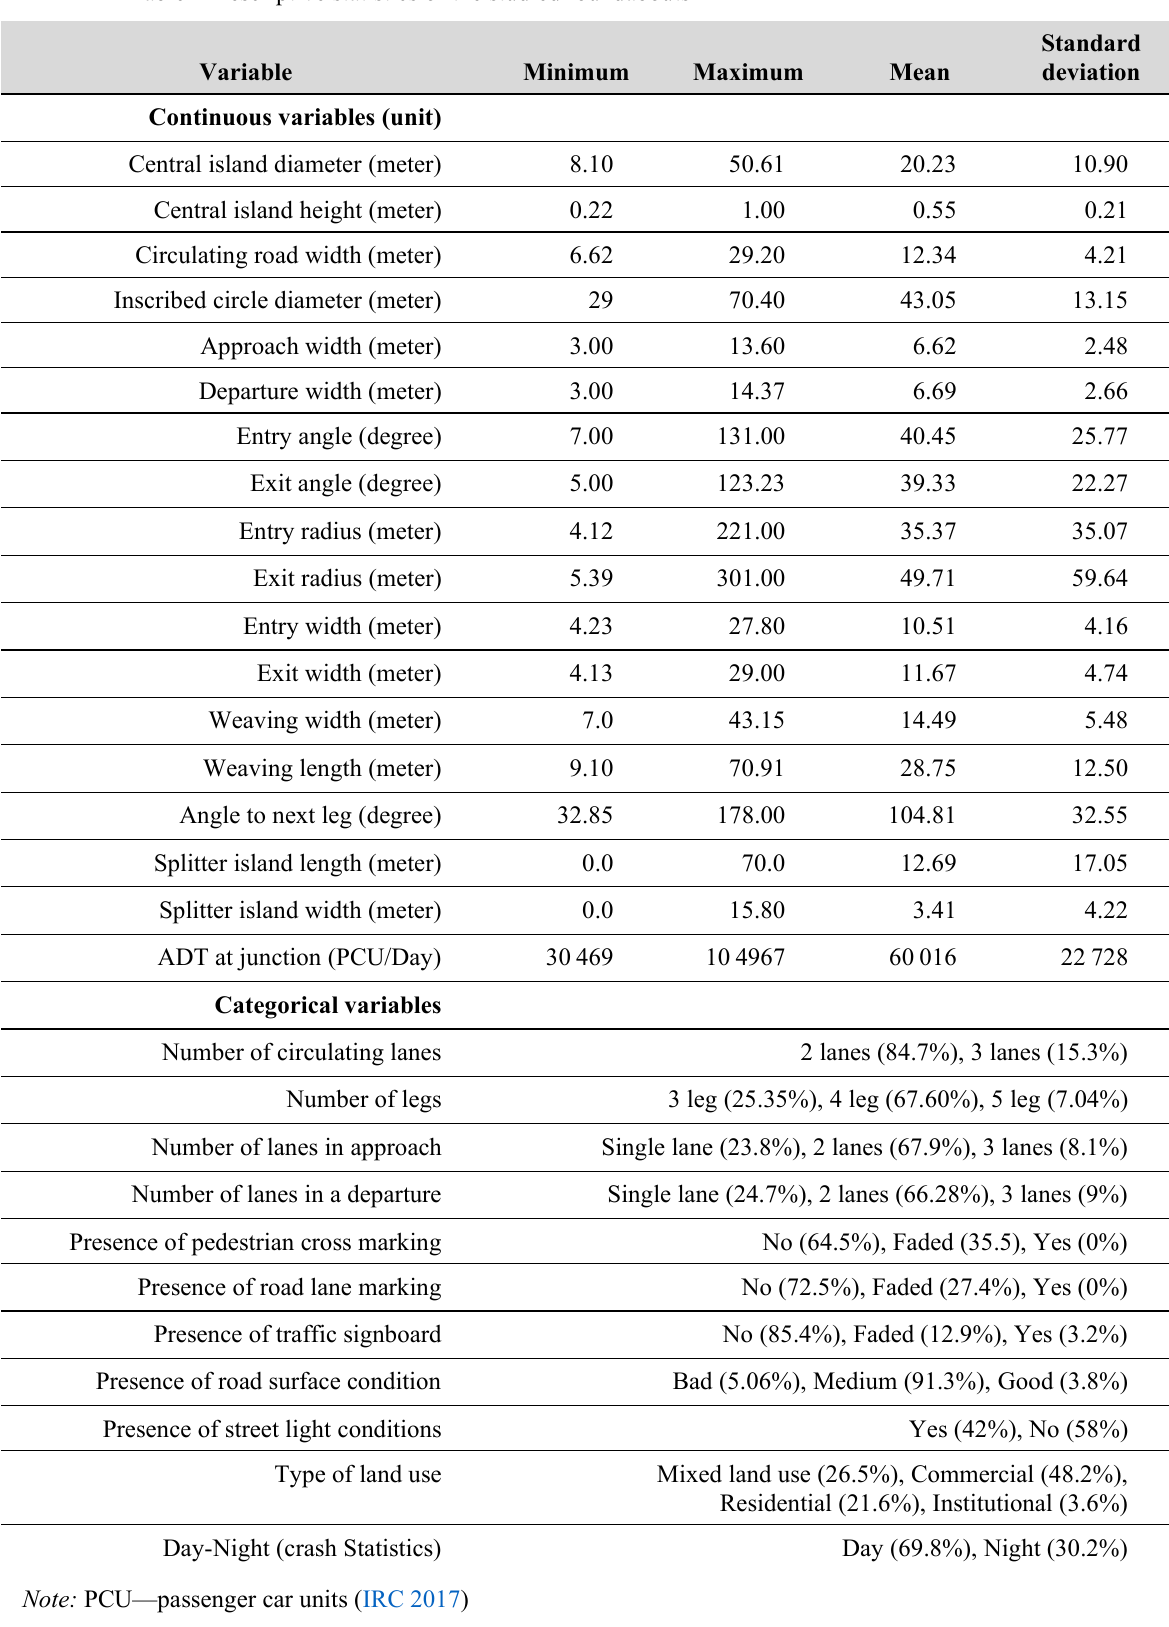
Standard deviation